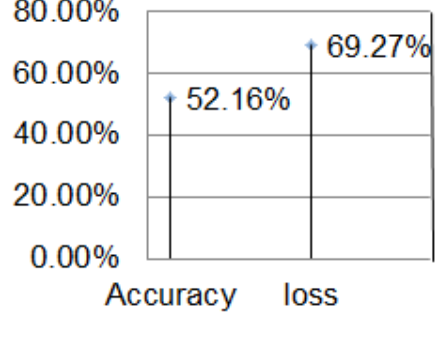
Fig.5.Accuracy and Loss using